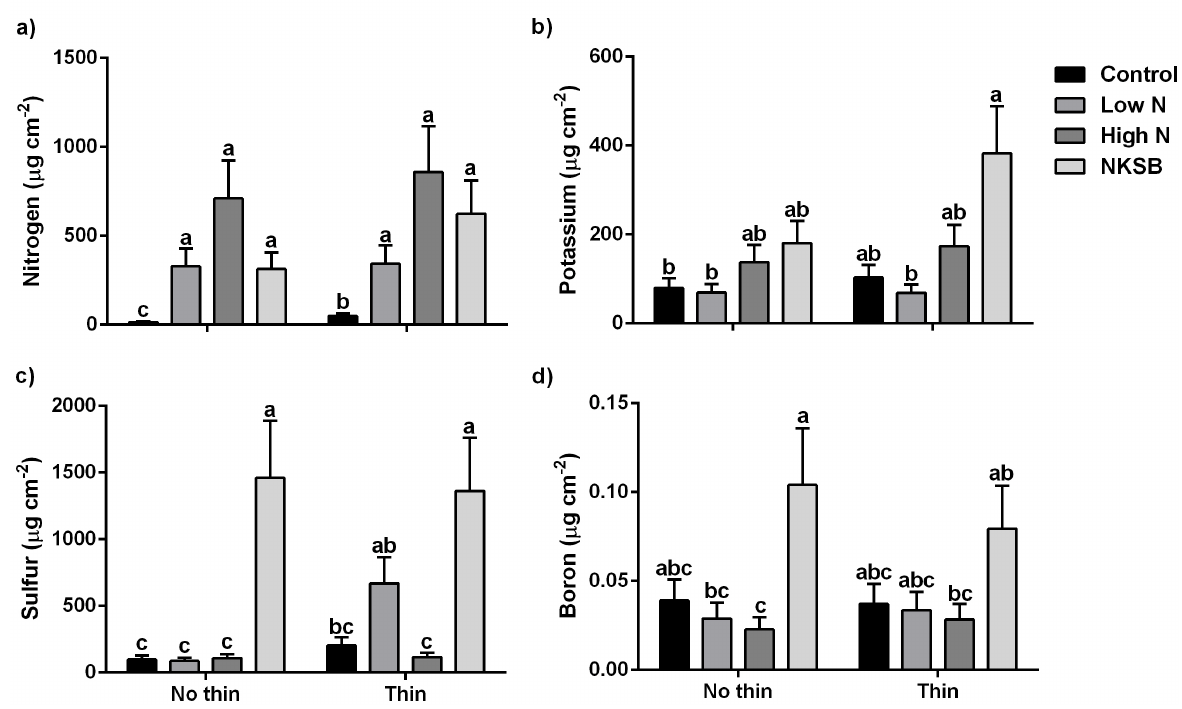
Figure 4. Soil ion exchange resin nutrient content (µg cm −2 ) for ( a ) N; ( b ) K; ( c ) S; and ( d ) B under various combinations of fertilization and stand thinning treatments. Data are presented as log back-transformed means (±SEM) of each nutrient by treatment. Different letters represent significant treatment effect at α = 0.05